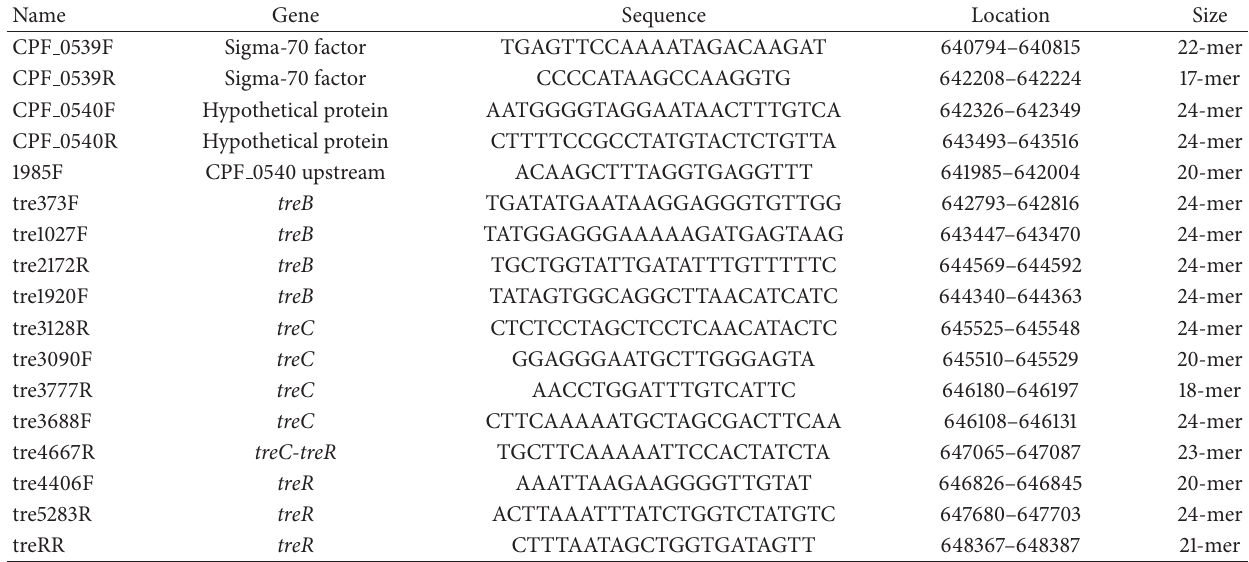
Table 1: Primers designed for the amplification of trehalose operon genes in C. perfringens along with the upstream regions.